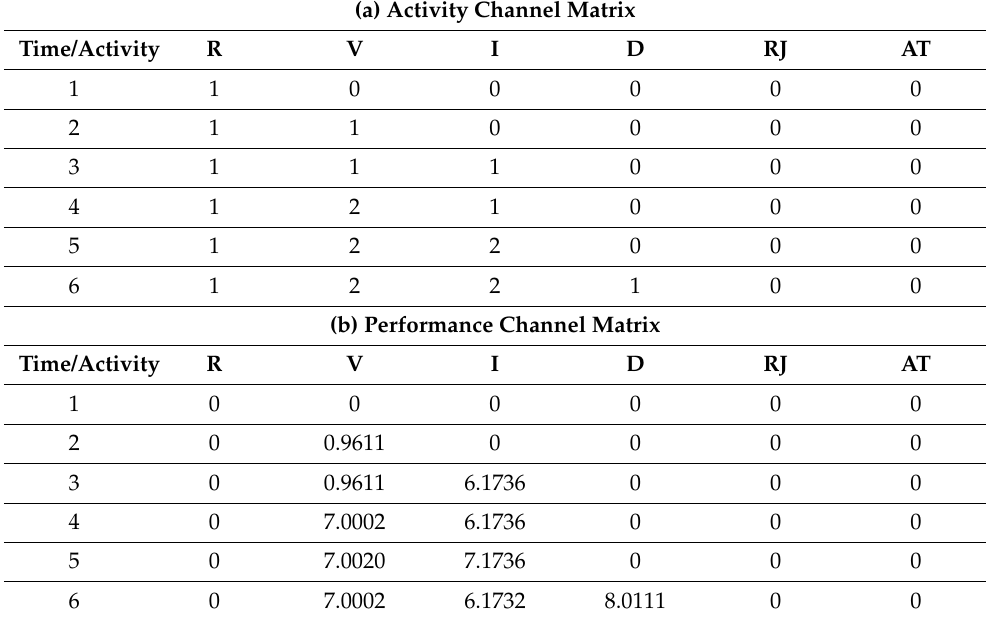
Table 2. Data matrix of prefix